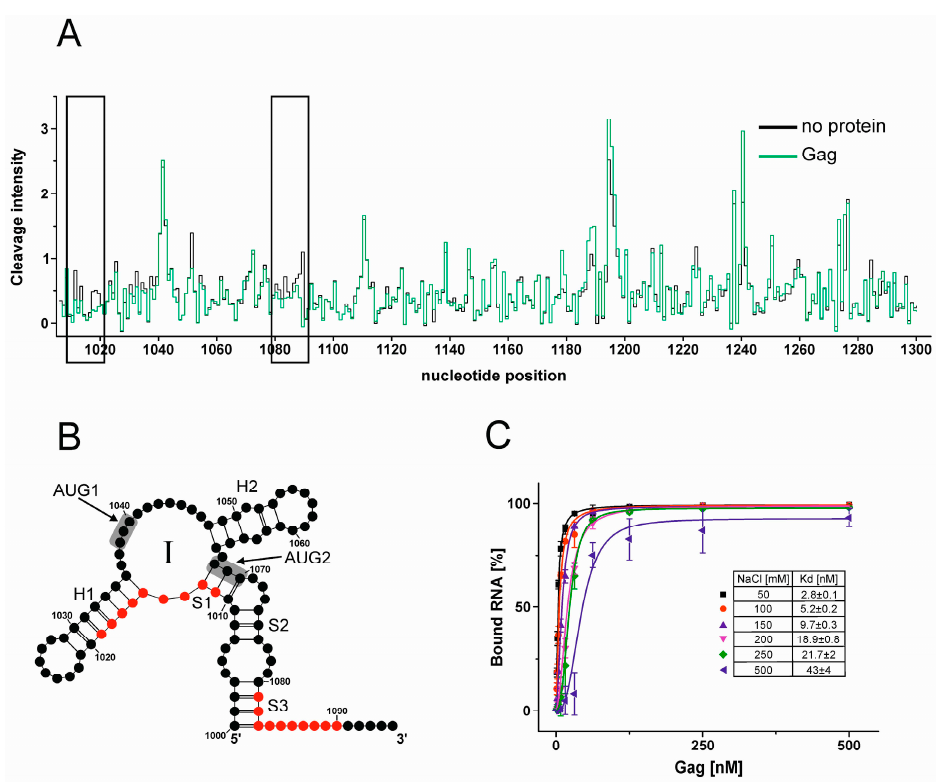
Figure 8. RNA binding properties of recombinant Ty1 Gag-p45. ( A ) Hydroxyl radical reactivity plots of protein free AUG1AUG2 RNA (black) in comparison with RNA probed in the presence of Gag (green). Regions showing consistent decreased reactivity over several nucleotides in the presence of Gag are boxed. ( B ) 2D structure model of Ty1i domain I with the positions protected from hydroxyl radical cleavage in the presence of the Ty1 Gag are indicated (red). ( C ) Filter-binding assay performed with Ty1i domain I RNA and Gag at different concentrations of NaCl (50–500 mM). The lines correspond to the best fit of the data. The error bars represent standard deviations. Kd: dissociation constant.